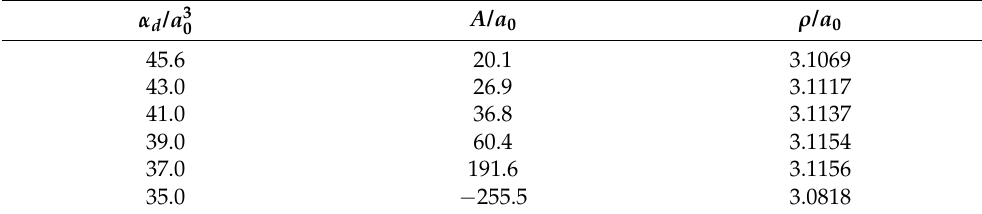
Figure 1. Scattering length A as a function of the dipole polarizability α d according to Equation (6). The curve was obtained with R = 2.750 a 0 in order to reproduce the scattering length obtained with the SMC. Table 2. Table for the polarizabilities and scattering lengths for the semiempirical